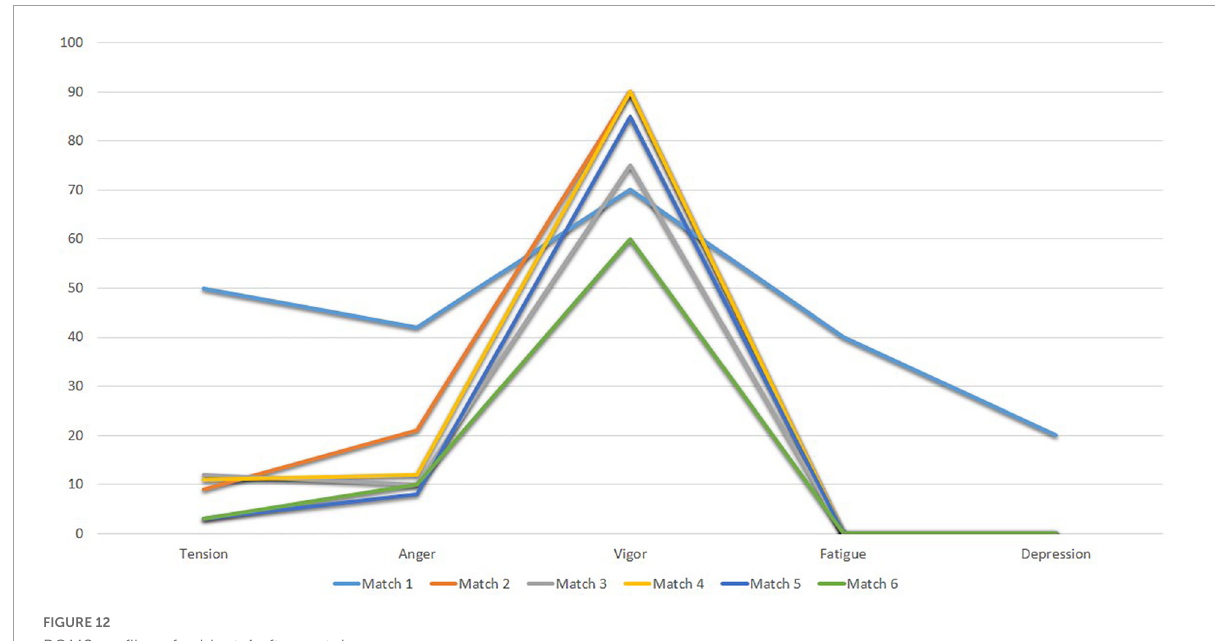
FIGURE12 POMS profiles of subject 4 after